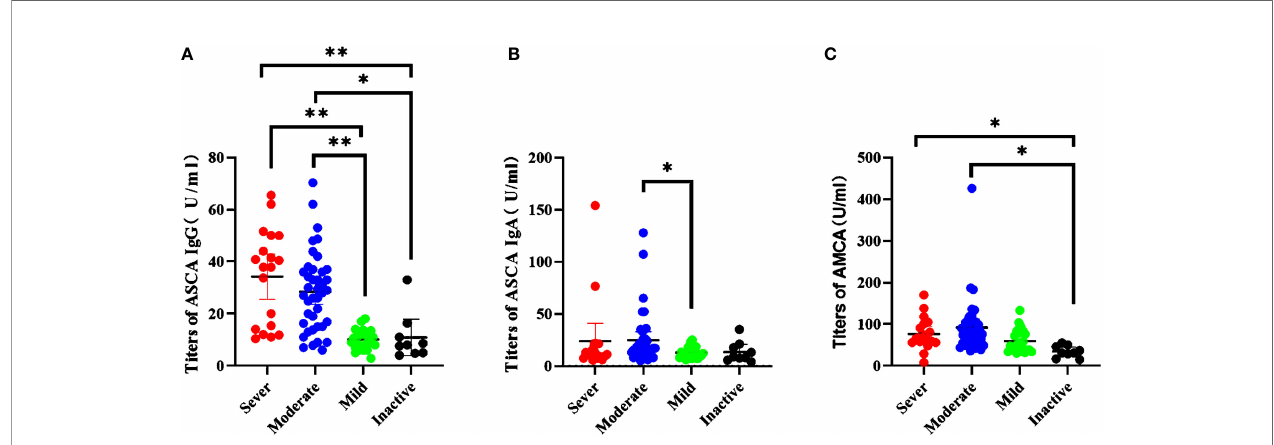
FIGURE 2 | Association between serological markers and the severity during the disease course in CD patients. (A) The titers of ASCA IgG in disease severity *P = 0.002, **P < 0.0001); (B) The titers of ASCA IgG in disease severity (P = 0.031); (C) The titers of AMCA in disease severity (sever vs inactive, P = 0.003; moderate vs inactive, P = 0.001).